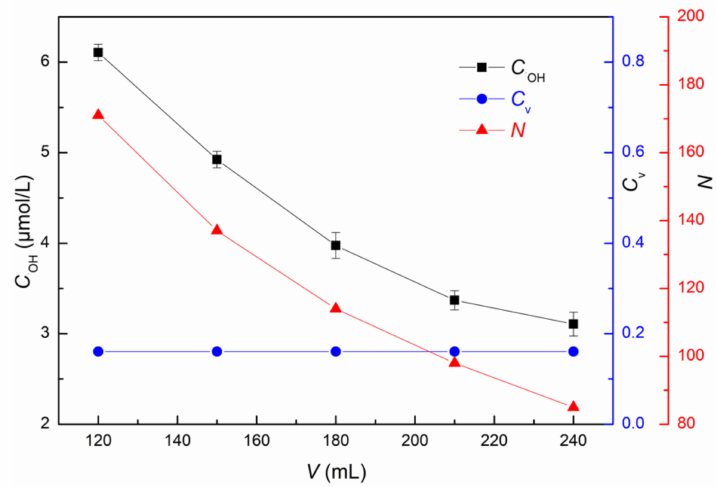
Figure 7. Influence of solution volume on · OH yield, C v , and N values. (Conditions: P i = 0.4 MPa, T = 30 ◦ C, d = 0.5 mm, t = 50 min.)